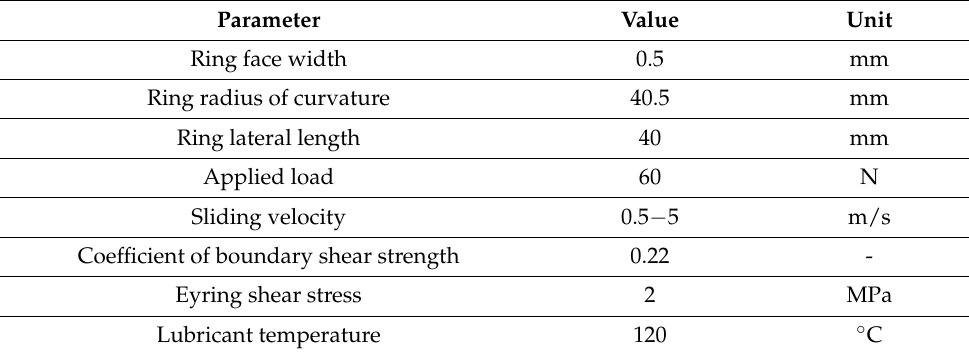
Table 2. Piston ring base dimensions and operating